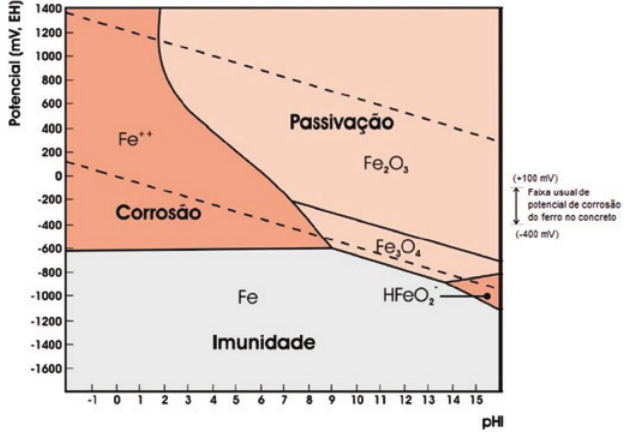
Diagrama de Pourbaix. Diagrama de equilíbrio termodinâmico para o sistema Fe–H delimitando os domínios prováveis de corrosão, passivação e imunidade